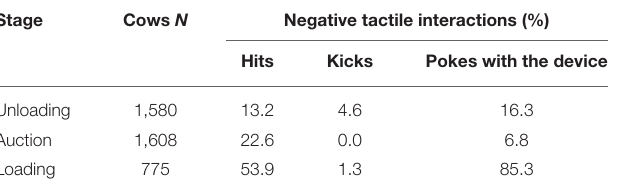
TABLE 3 | Descriptive analysis of negative tactile interactions observed in the cows during unloading, auction and loading at the livestock markets. Stage Cows N